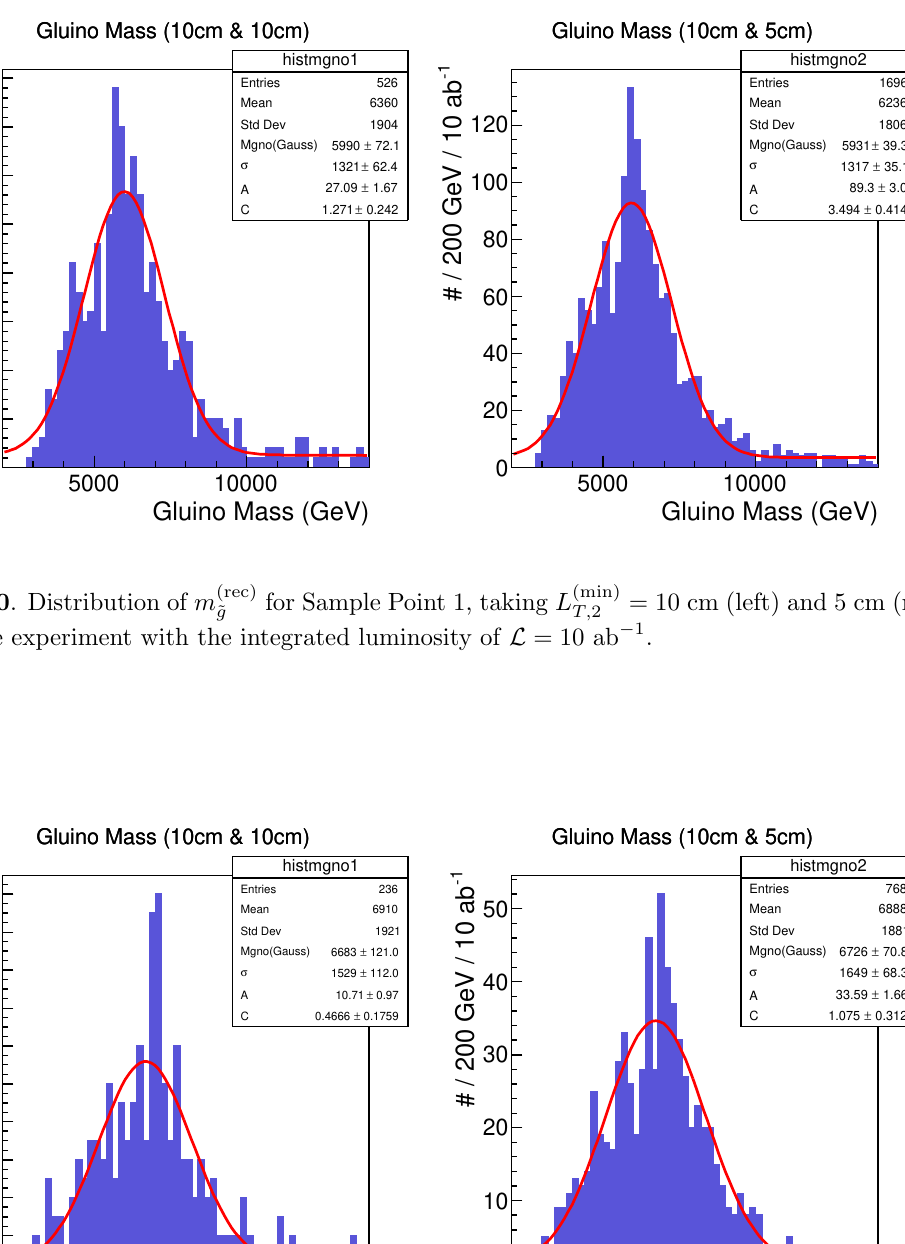
for Sample Point 2, taking L (min) = 10 cm (left) and 5 cm (right) ~ g T; 2